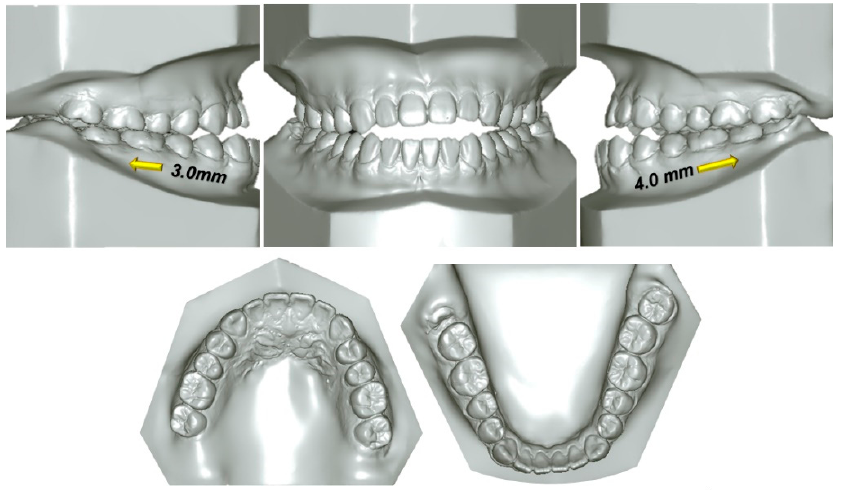
Figure 2. Pretreatment dental casts. The required amount of distalization at the crown level on the dental cast (Right, 3.0 mm; Left, 4.0 mm) to establish a Class I molar relationship. The panoramic radiograph showed the presence of four third molars. The lateral cephalometric analysis indicated a skeletal Class III relationship with a protruded mandible (SNA, 81.7 ◦ ; SNB, 85.4 ◦ ; ANB, − 3.7 ◦ ; AO-BO, − 9.8 mm; APDI, 92.4), and a normal vertical facial pattern [mandibular plane angle (SN-MP), 29.5 ◦ ; facial height ratio, 70.5%]. The maxillary and mandibular incisors were compensated (U1 to FH, 127.6 ◦ ; IMPA, 86.7 ◦ ) by a skeletal Class III pattern. The maxillary occlusal plane angle was − 3.5 ◦ and the mandibular occlusal plane angle was 7.8 ◦ . The upper and lower lips to the esthetic line were − 4.8 mm and − 1.3 mm, respectively. NLA was 99.5 ◦ , and the Z angle was 85.7 ◦ (Figure 3, Table 1).